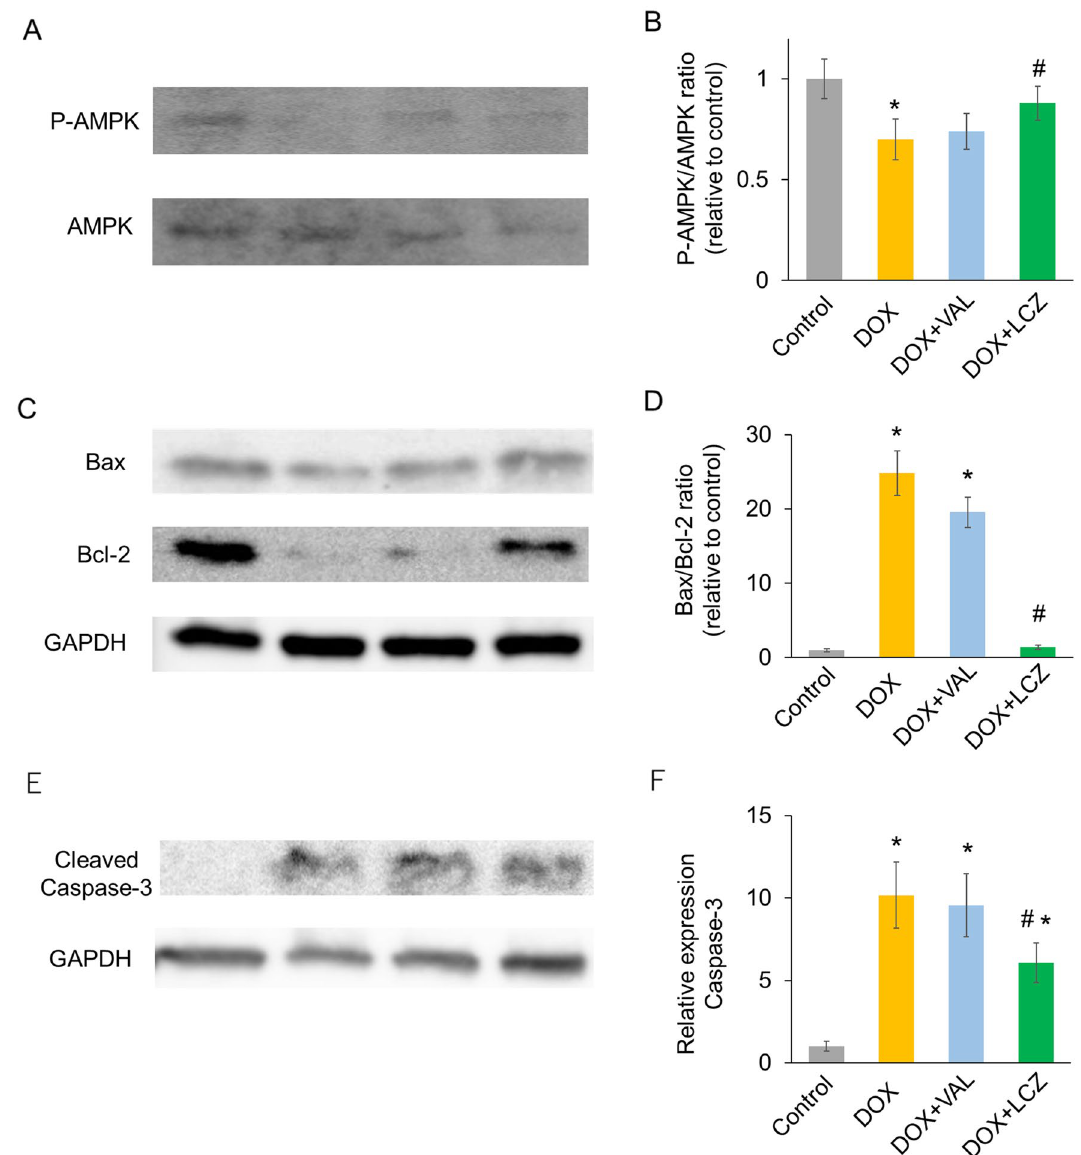
Figure 3. Effect of valsartan and LCZ696 on activation of AMPK and the expression of Bax, Bcl-2, and cleaved caspase3 in rat hearts treated with doxorubicin. ( A ) Representative western blot images of the expression of phosphorylated- and total-AMPK in the cardiac tissue on day 18. ( B ) The ratio of p-AMPK/AMPK as measured by western blotting. DOX significantly decreased the ratio of p-AMPK/AMPK, which LCZ significantly increased, but not VAL. ( C ) Representative western blot images of the expression of Bax and Bcl-2 in the cardiac tissue on day 18. ( D ) The ratio of p-AMPK/AMPK as measured by western blotting. DOX significantly increased the ratio of Bax/Bcl-2, which LCZ significantly reduced, but not VAL. ( E ) Representative western blot images of the expression of cleaved caspase-3 in the cardiac tissue on day 18. ( F ) Protein expression of cleaved caspase-3 as measured by western blotting. DOX significantly increased the level of caspase-3, which LCZ significantly reduced, but not VAL. Data are expressed as the mean ± standard error. * p < 0.05 versus control and # p < 0.05 versus p-AMPK; phosphorylated adenosine monophosphate-activated protein kinase; DOX, doxorubicin; VAL, valsartan; LCZ,